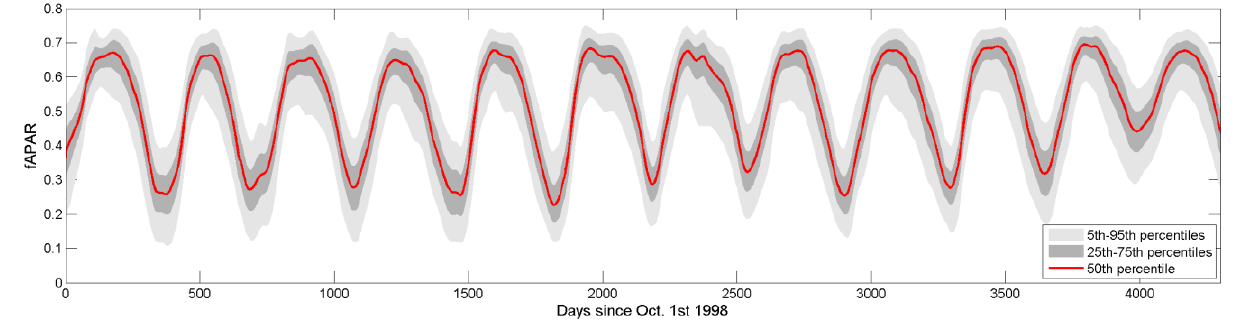
Figure 7. Distribution of all smoothed time series with π ≥